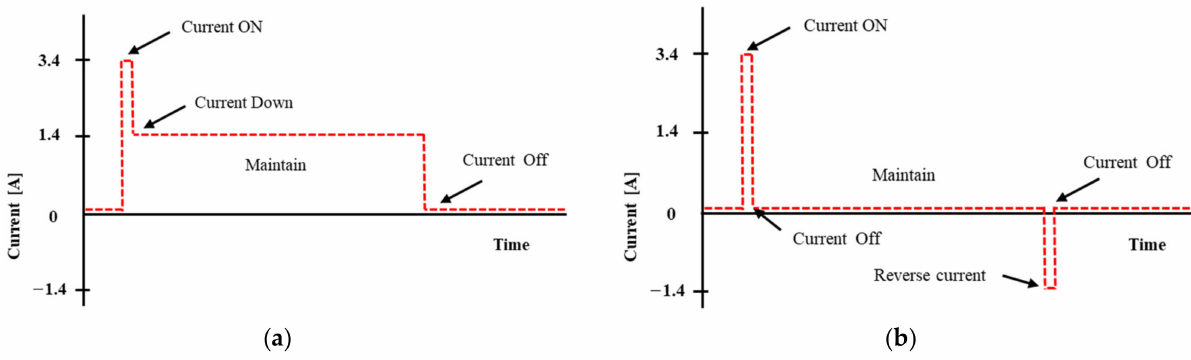
Figure 2. Comparison of the conventional TCV and permanent magnet TCV operation methods: ( a ) Conventional TCV operation method; ( b ) Permanent magnet TCV operation